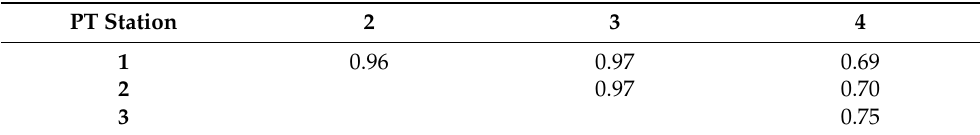
Table 9. Correlation of the displacement along the vertical direction (Z-axis) of all the possible couple of points.